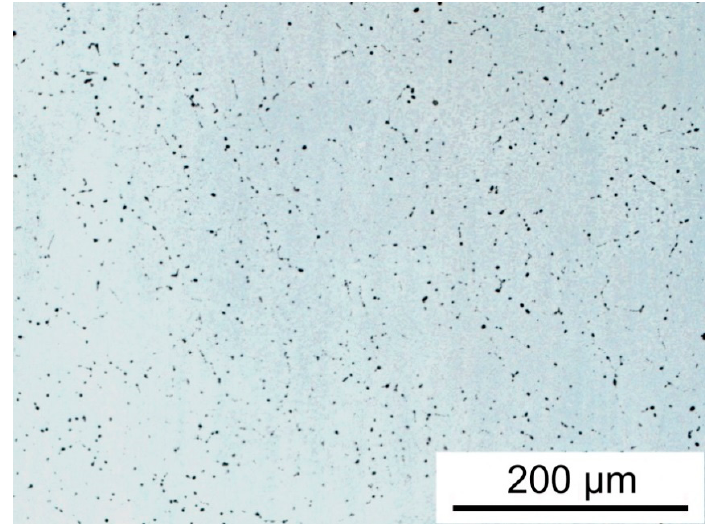
Figure 2. Structure of as-cast grains and intermetallic phase–cast rod, homogenized.